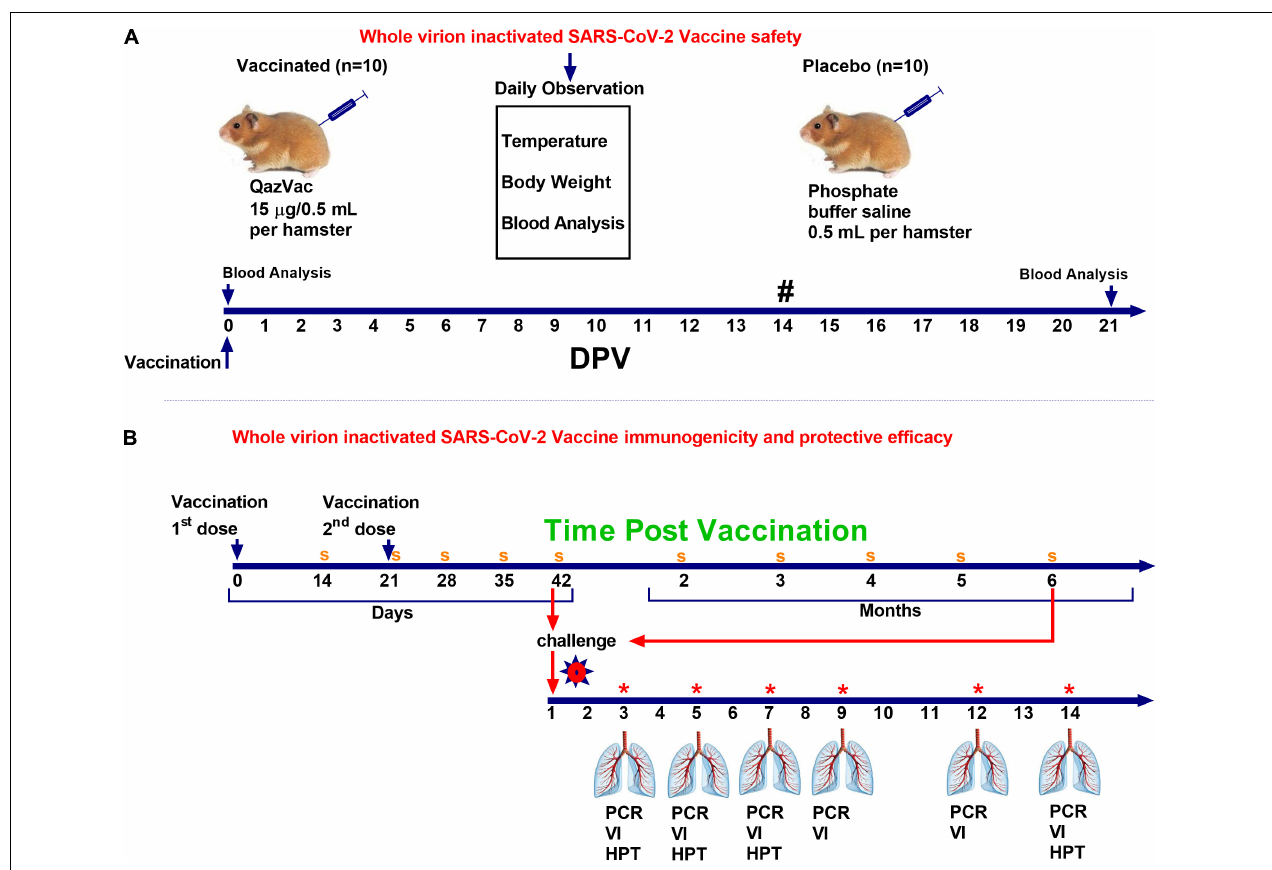
FIGURE 2 | Study design of QazCovid-in vaccination in Syrian hamsters. (A) The study of the safety of the inactivated QazCovid-in vaccine in Syrian hamsters. (B) The determination of immunogenicity and evaluation of the protective efficacy of the inactivated QazCovid-in vaccine in Syrian hamsters. PCR, polymerase chain reaction; VI, virus isolation; HPT, histopathology. Notes (#)—measurement of body temperature and body weight was carried out within 14 days. (s)—sampling of blood serum to determine the titer of viurs-neutralizing antibodies (*)—on 3, 5, 7, 9, 12, and 14 DPI, samples of nasal and oral swabs were collected and examined by PCR and viral isolation in cell